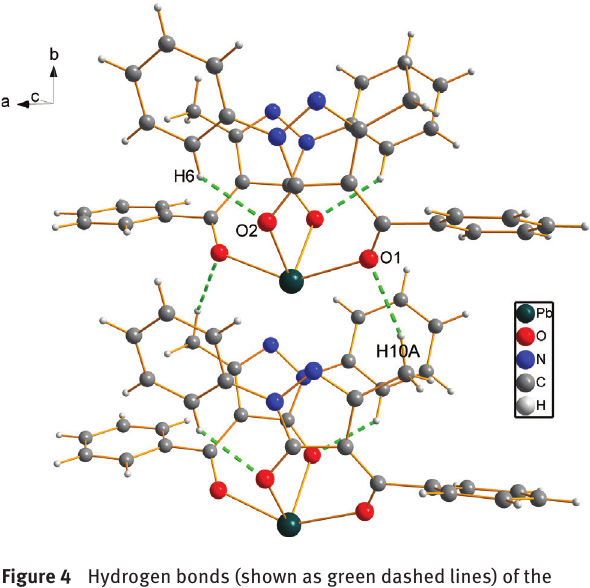
Figure 4 Hydrogen bonds (shown as green dashed lines) of the complex. Table 2 H-bonding geometry parameters (Å and ° ) for the title compound.